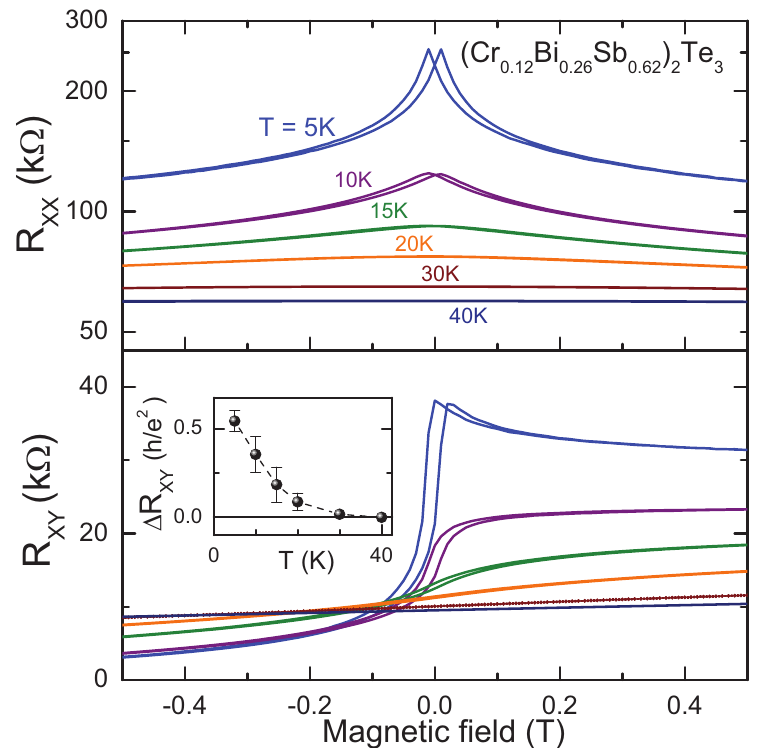
Figure 5. Magnetoresistance data in (Cr 0.12 Bi 0.26 Sb 0.62 ) 2 Te 3 film at various temperatures. Top: diagonal resistivity; bottom: Hall resistivity. The inset shows the absolute values of the step in the Hall resistance at zero magnetic field and as a function of